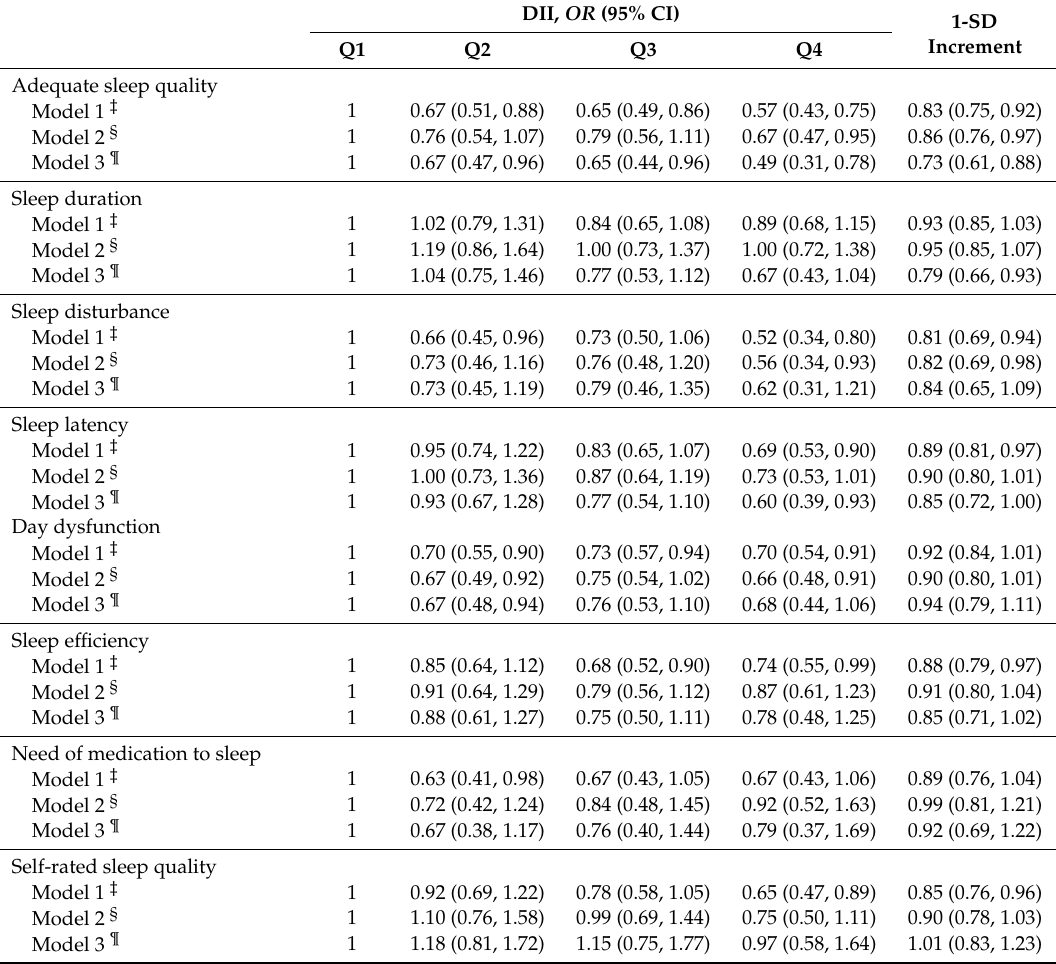
Table 4. Association between overall and individual domains of sleep quality † by quartiles of the